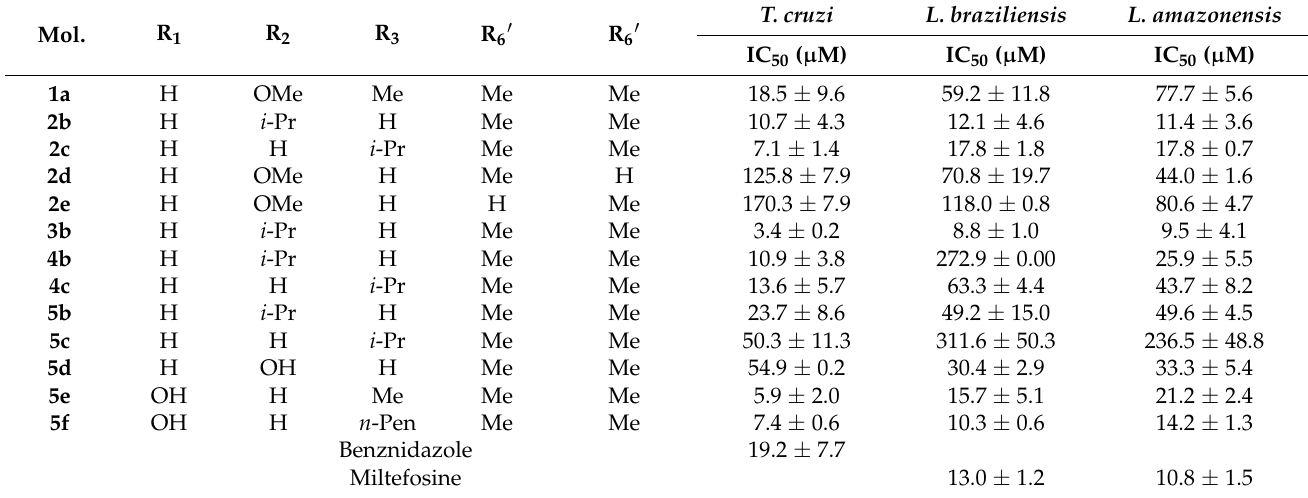
Table 1. Antileishmanial and antitrypanosomal activity pulchrol derivatives, compared to the positive controls benznidazole and miltefosine. See experimental for details about the assays. Mol.